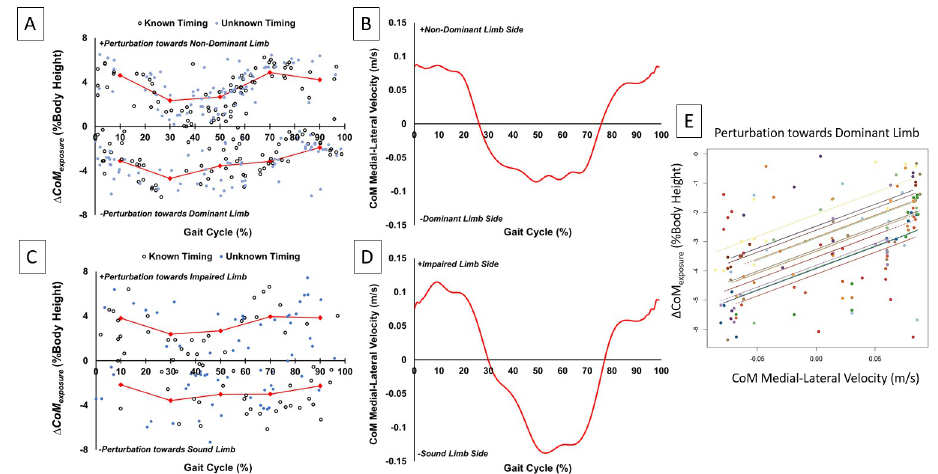
Fig 6. Plots of Δ CoM and average CoM medial-lateral velocity against gait cycle for control (A and B, exposure respectively) and BKPU (C and D, respectively) participants. The connected red diamonds in plots A and C represent average displacement values for each 20% of the gait cycle to demonstrate how displacement varies over the gait cycle and has a similar shape to CoM velocity (B and D). Start of the gait cycle (0%) represents non-dominant or impaired limb initial contact. A representative scatterplot generated from the repeated-measures correlation analysis (E) demonstrates the positive linear relationship between CoM velocity and displacement for each able-bodied participant (denoted by different colors).